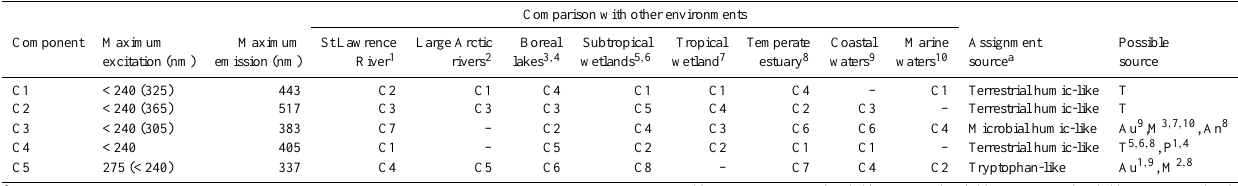
Table 1. Spectral characteristics of the five fluorophores identified by PARAFAC modeling, correspondence with previously identified com- ponents in different environments, general assignment, and possible source. Numbers in brackets refer to the second peak of maximal